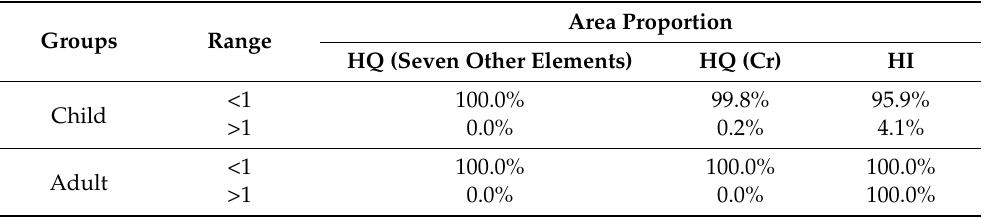
Figure 8. Health risks of heavy metal in soil for children and adults. ( a ) Non-carcinogenic risk; ( b ) Carcinogenic risk. (Elements without risk were not displayed). Table 8. Area proportion of non-carcinogenic risk.